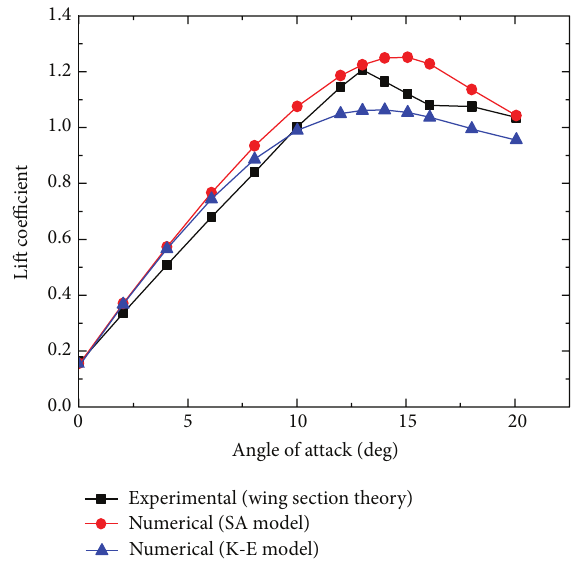
Figure 4: Lift coefficient comparison between numerical and experimental results.